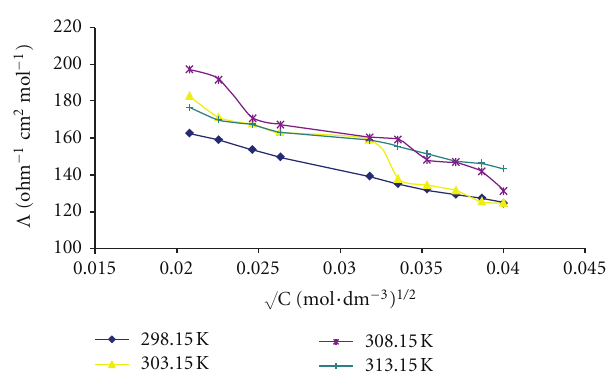
F 5: Molar conductance versus square root of concentration for Mn-succinate at different